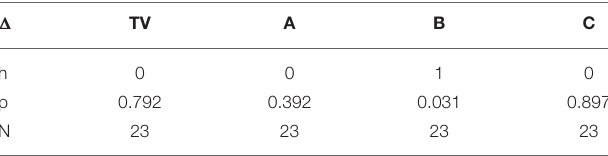
TABLE 5 | Using only mean eVAS, the reported pain comparison for Cold 1 vs. Cold 2 differs significantly only for analgesic